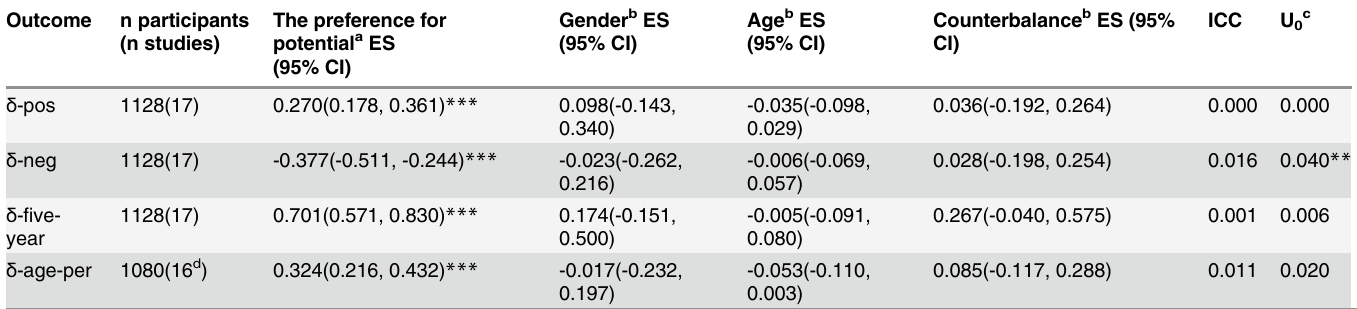
Table 3. The preference for potential effect adjusted for participant gender and age and counterbalancing